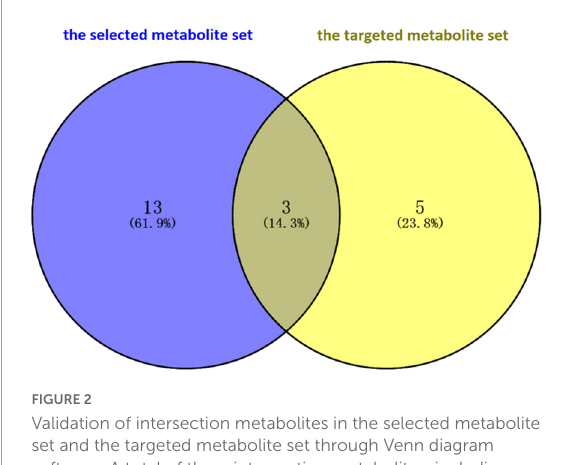
FIGURE2 Validation of intersection metabolites in the selected metabolite set and the targeted metabolite set through Venn diagram software. A total of three intersection metabolites, including butyrate, tyrosine, and phenylalanine, were obtained. Then, the three metabolites (butyrate, tyrosine, and phenylalanine) were validated that they were highly associated with Parkinson’s disease.